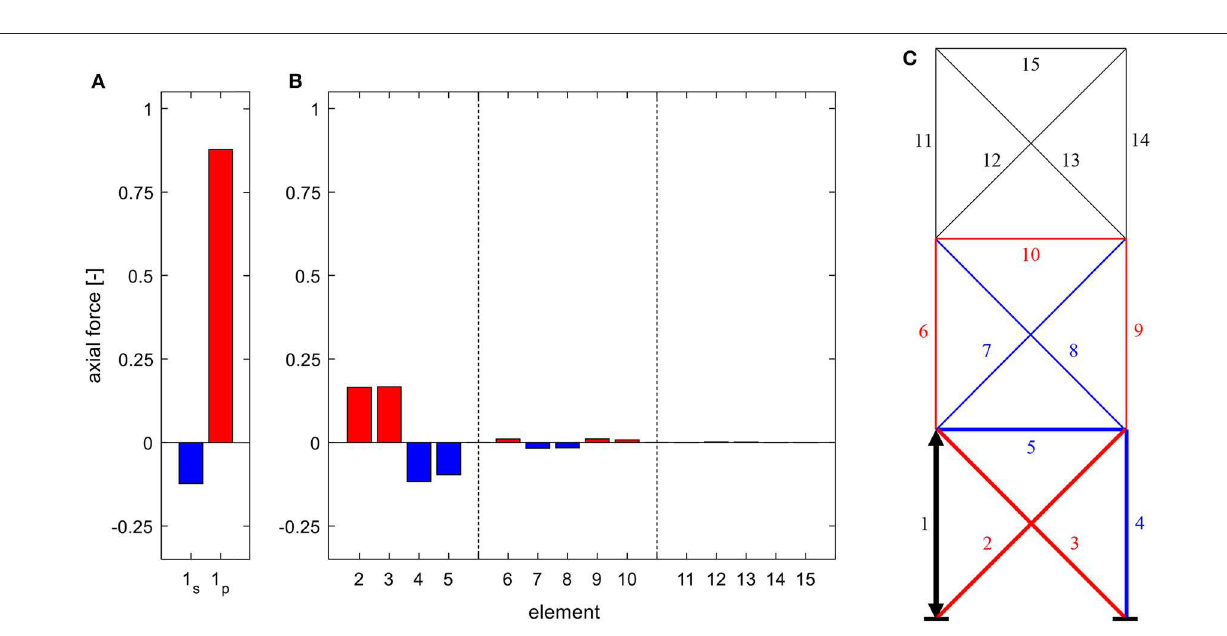
FIGURE 7 | Axial forces in (A) the actuated element for serial (index s ) and parallel (index p ) linear actuation, (B) the remaining structure due to the actuation of element 1 (C) , for a truss with rigid